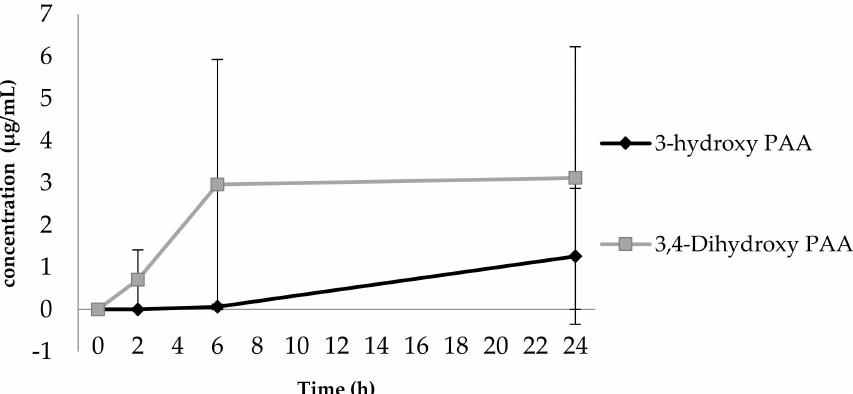
Figure 2. Production of 3,4-diOHPAA from the degradation of 3-OHPAA. The plateauing of 3,4-DiOHPAA at 6 h concomitantly to the increase in production of 3-OHPAA at 6 h is demonstrated as mean ( ±